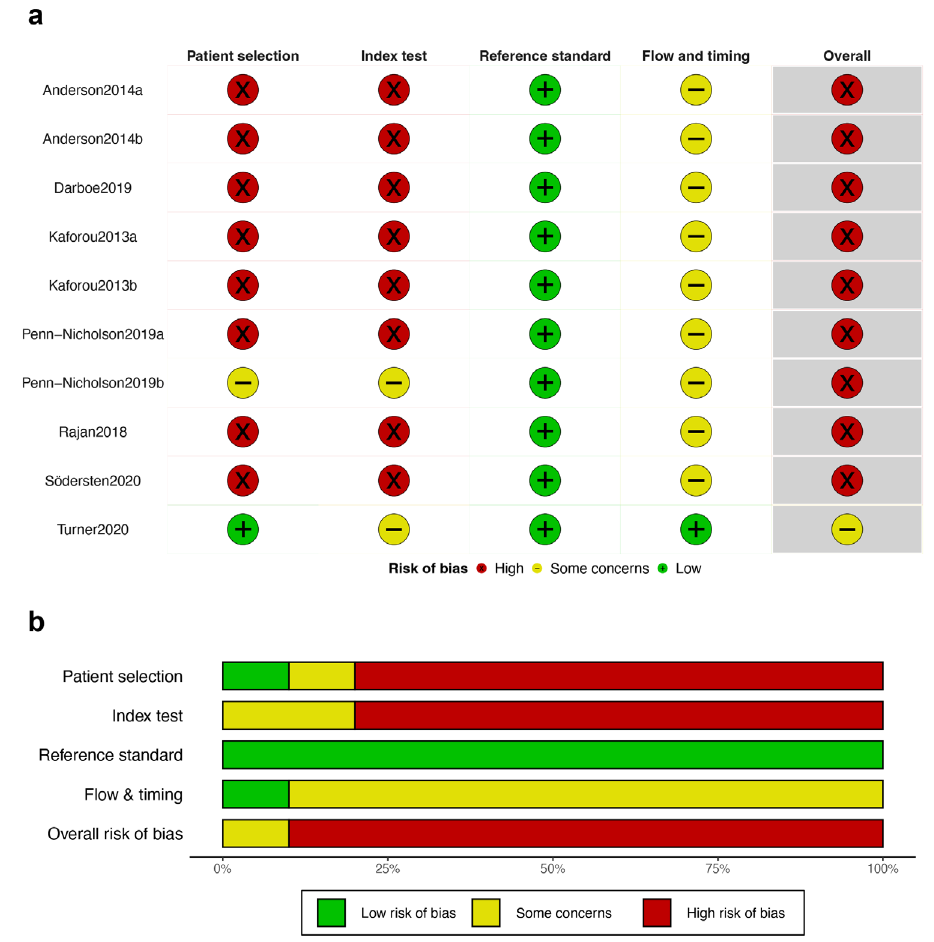
Figure 2. Quality Assessment of Diagnostic Accuracy Studies-2 (QUADAS-2). ( a ) Assessment of bias in individual cohorts included in the systematic review and ( b ) summary of results of the QUADAS-2 assessment in the four domains: patient selection, index test, reference standard, and flow and